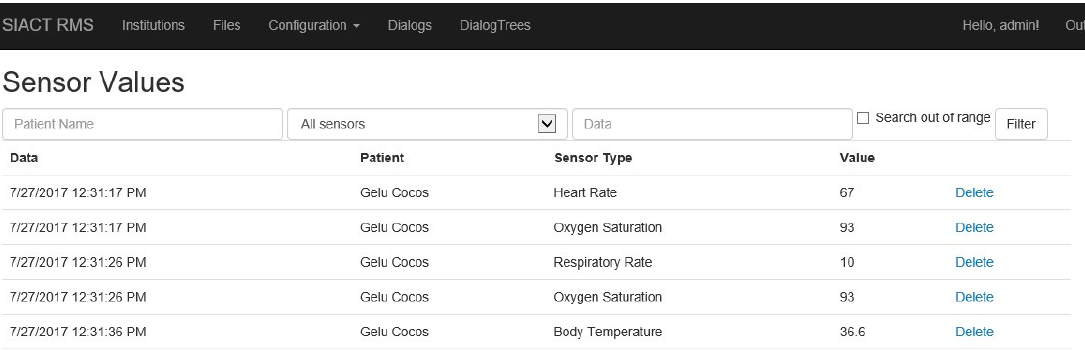
Figure 16. Defining the types of sensors used in the Patient WEB Application.